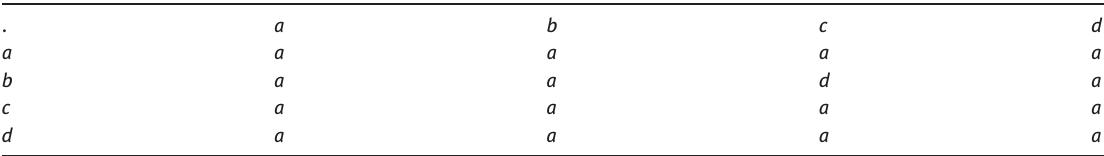
Table 2: Multiplication table of S = { a , b , c , d }.